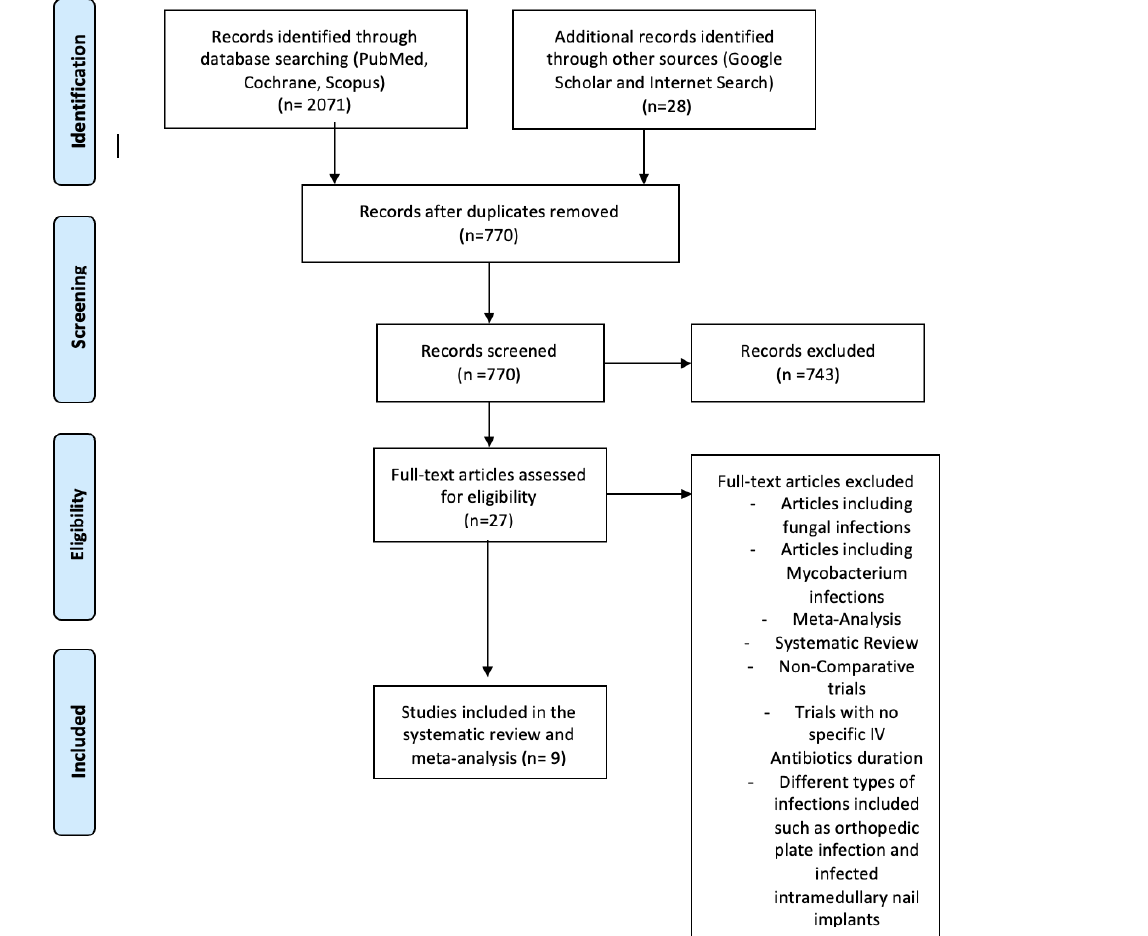
Figure 1. Preferred Reporting Items for Systematic Reviews and Meta-Analyses (PRISMA) flow diagram showing the study selection process. IV denotes